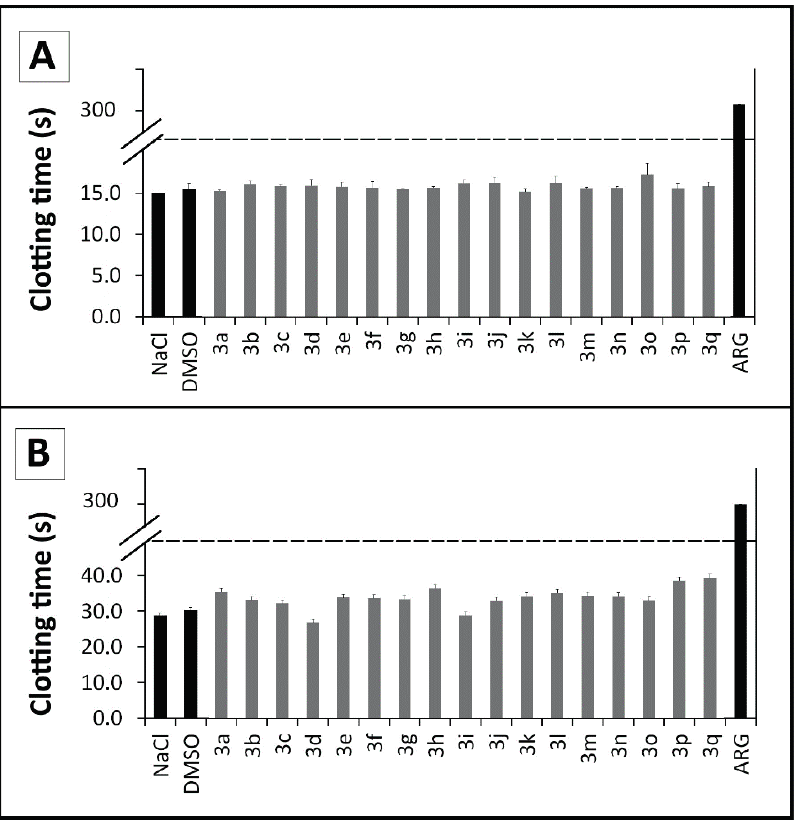
Figure 2. Evaluation of N,N' -disubstituted thiourea derivatives and argatroban (ARG) on the in vitro coagulation of human pooled plasma ( n = 6) by activated partial thromboplastin time—aPTT ( A ) and prothrombin time—PT ( B ) assays. All derivatives and argatroban at 100 μ M; DMSO at 1% and NaCl at 0.25